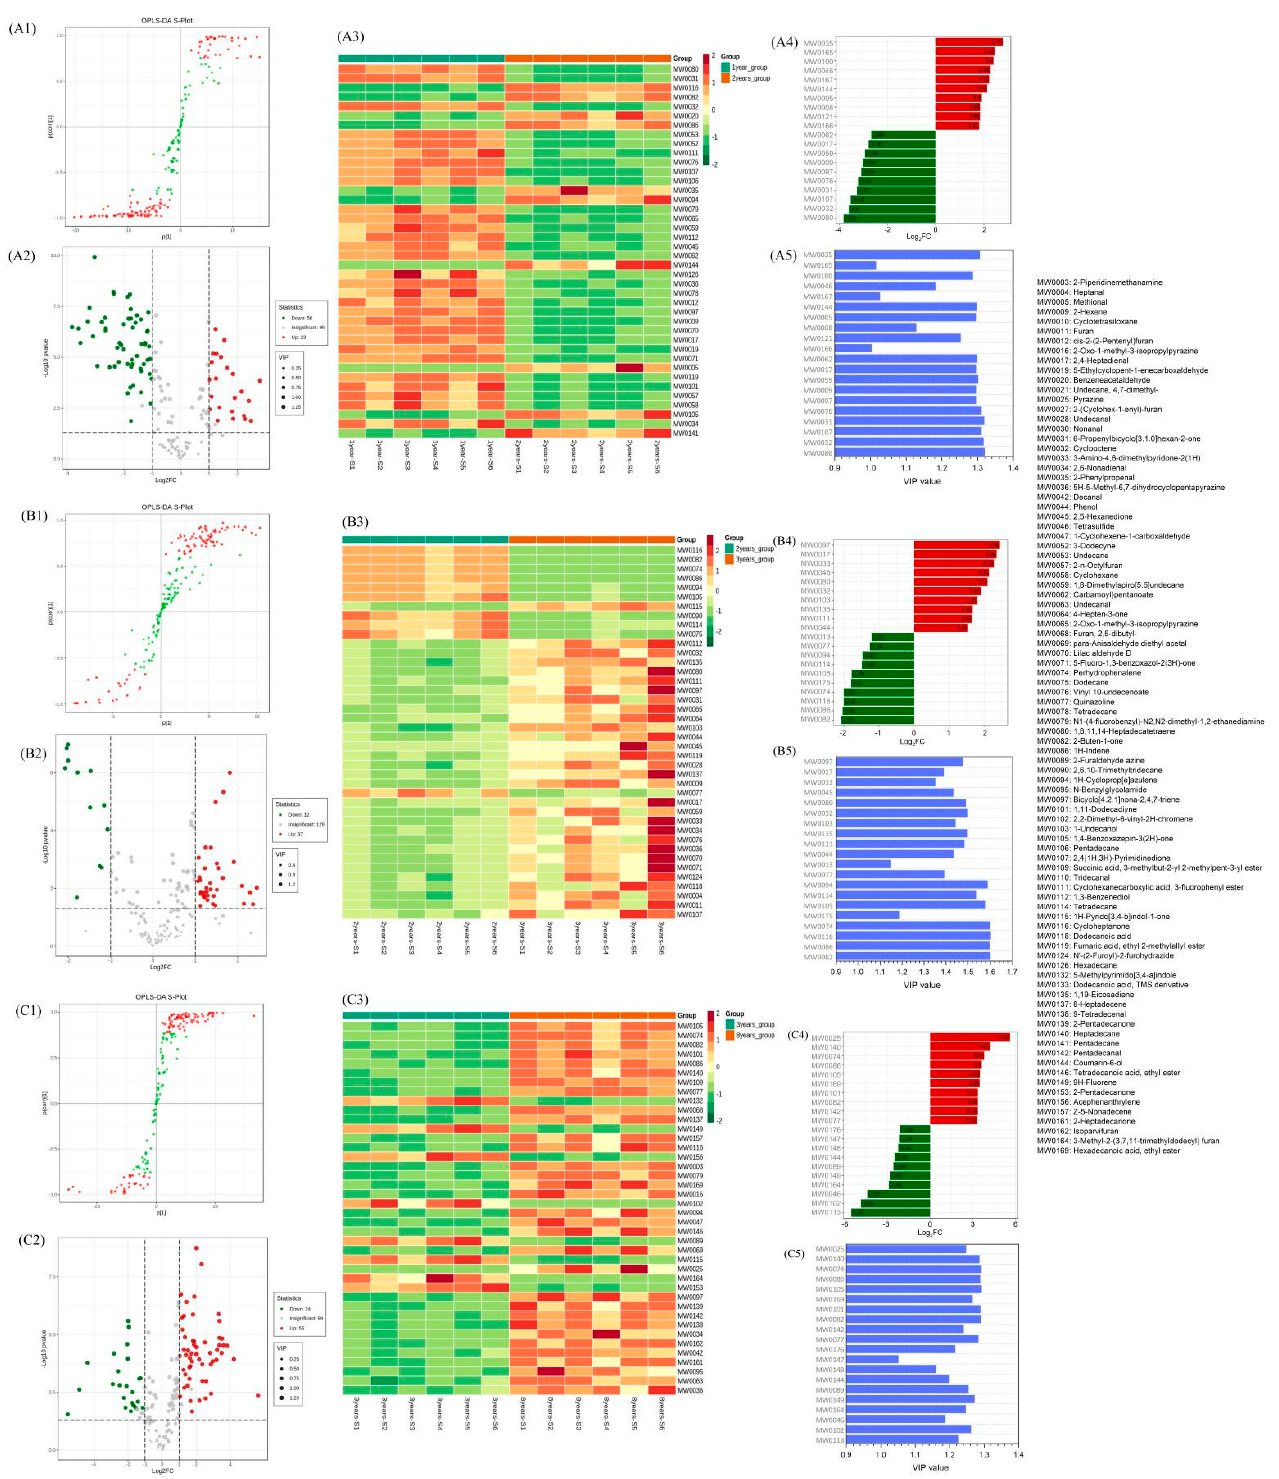
Figure 7. The OPLS-DA analysis ( A1 , B1 , C1 ), between-group comparative analysis ( A2 – A5 , B2 – B5 , C2 – C5 ) of VOCs in all shrimp paste samples fermented for 1, 2, 3, and 8 years. of VOCs in all shrimp paste samples fermented for 1, 2, 3, and 8